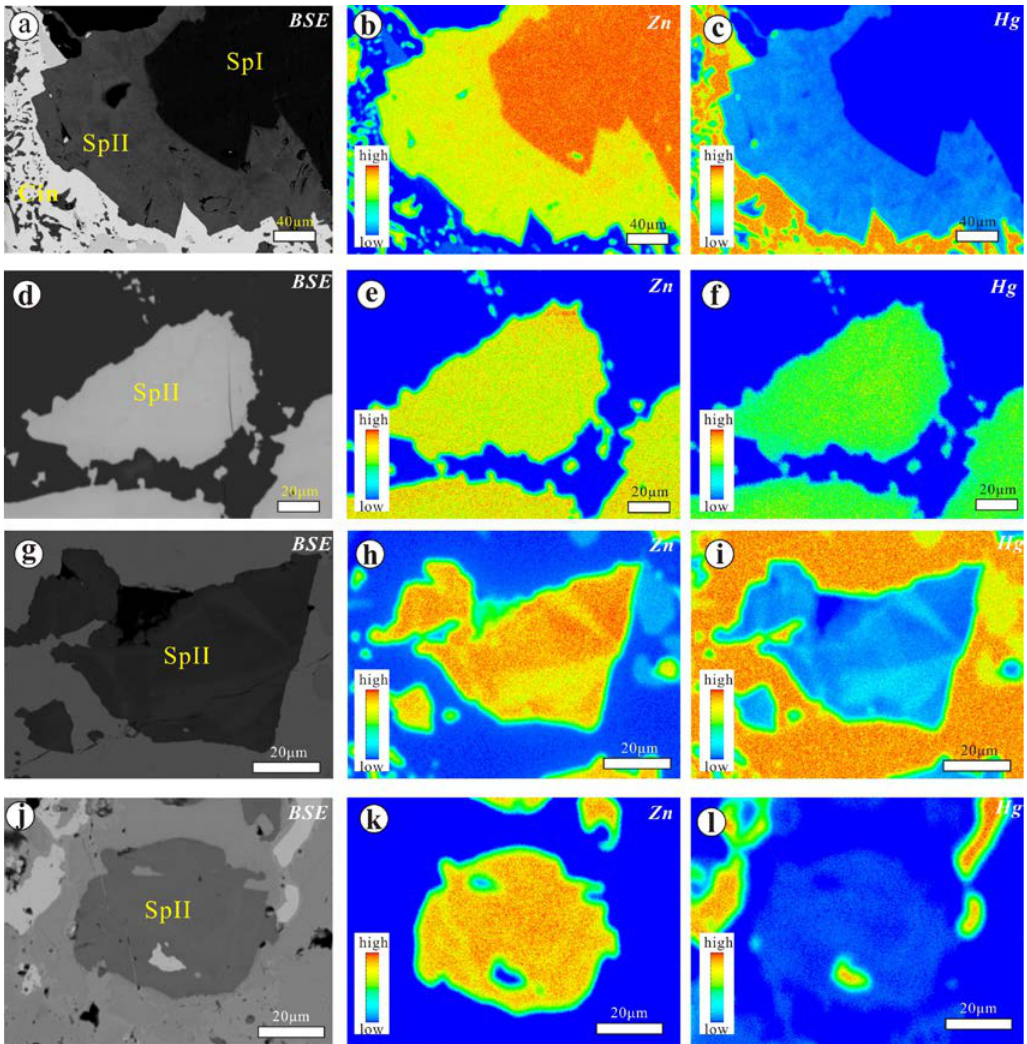
Figure 8. Backscattered electron images ( a , d , g , j ); and X-ray element-distribution maps for Zn ( b , e , h , k ); and Hg ( c , f , i , l ) of different occurrences of sphalerite II (SpII): ( a – f ) Zn and Hg maps of sphalerite II in